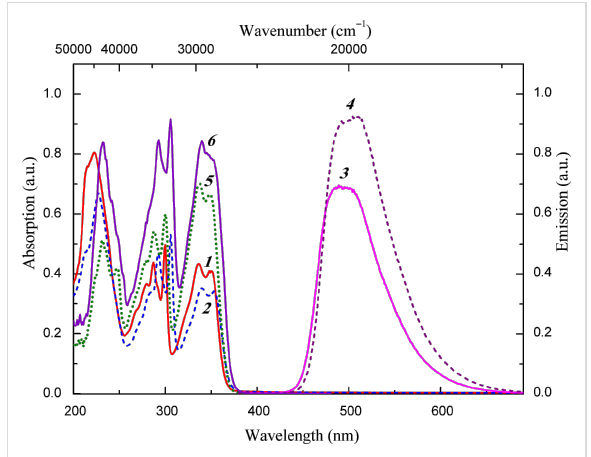
Figure 5: Electronic absorption (1, 2), fluorescence emission ( λ exc = 350 nm) (3, 4) and fluorescence excitation [ λ obs = 495 nm (5), λ obs = 510 nm (6)] spectra of 11c (1, 3, 5) and 11d (2, 4, 6) in heptane solu- tion ( c = 2 ∙ 10 − 5 mol × L − 1 , l = 1 cm) at 293 K.